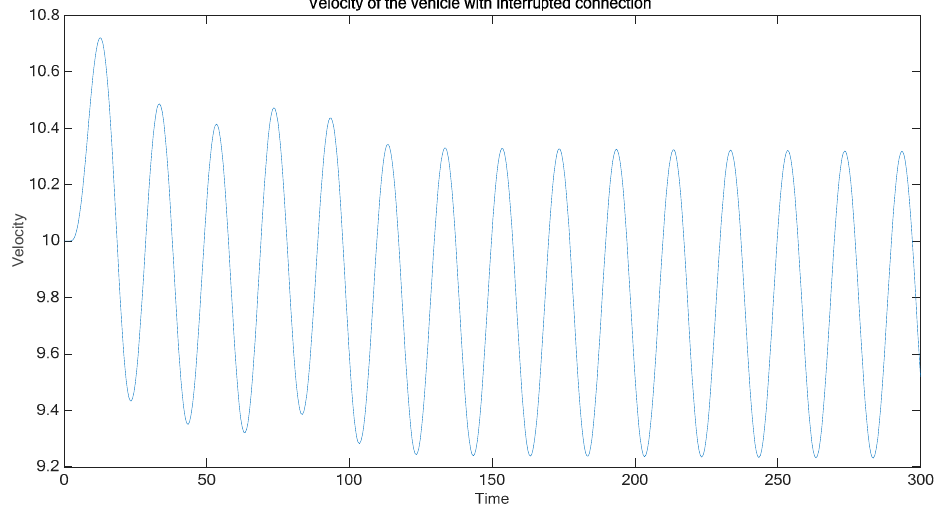
Figure 22. Percentage of samples with nondimensional barycenter’s velocity greater than 10% plotted versus the probability of long-range connection.